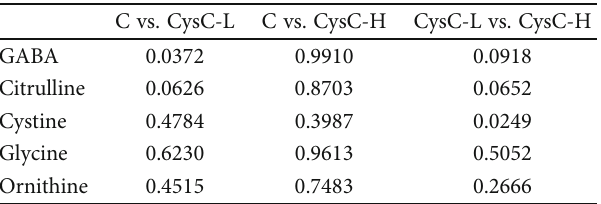
Table 8: Probability of comparison among groups for each amino acid (Table